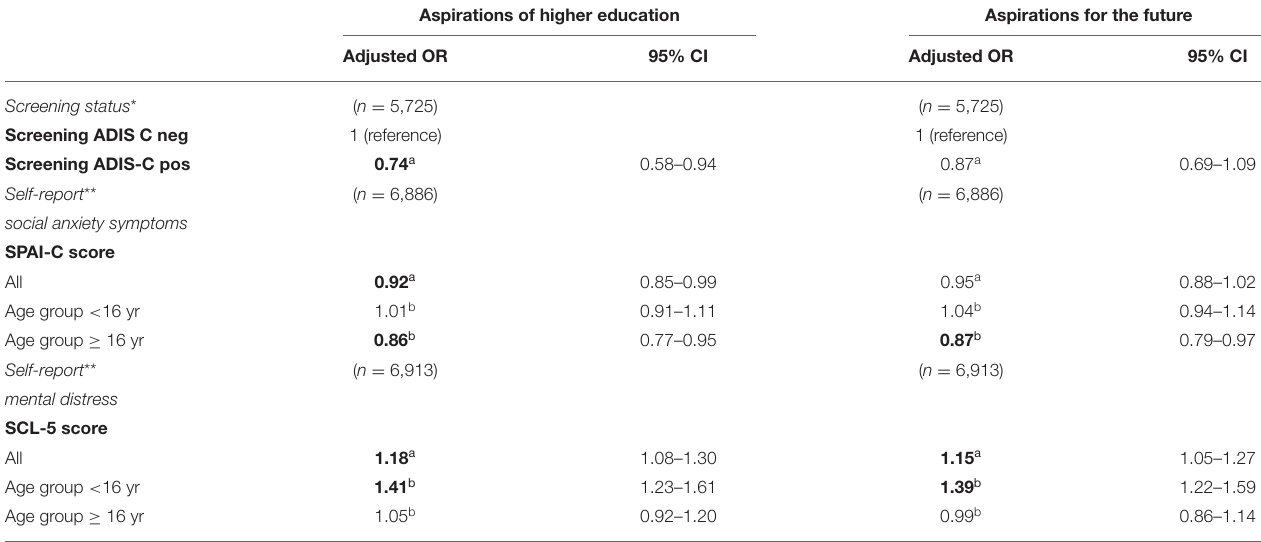
TABLE 3 | Associations between various degrees of social anxiety symptoms and mental distress, and aspirations of higher education and aspirations for the